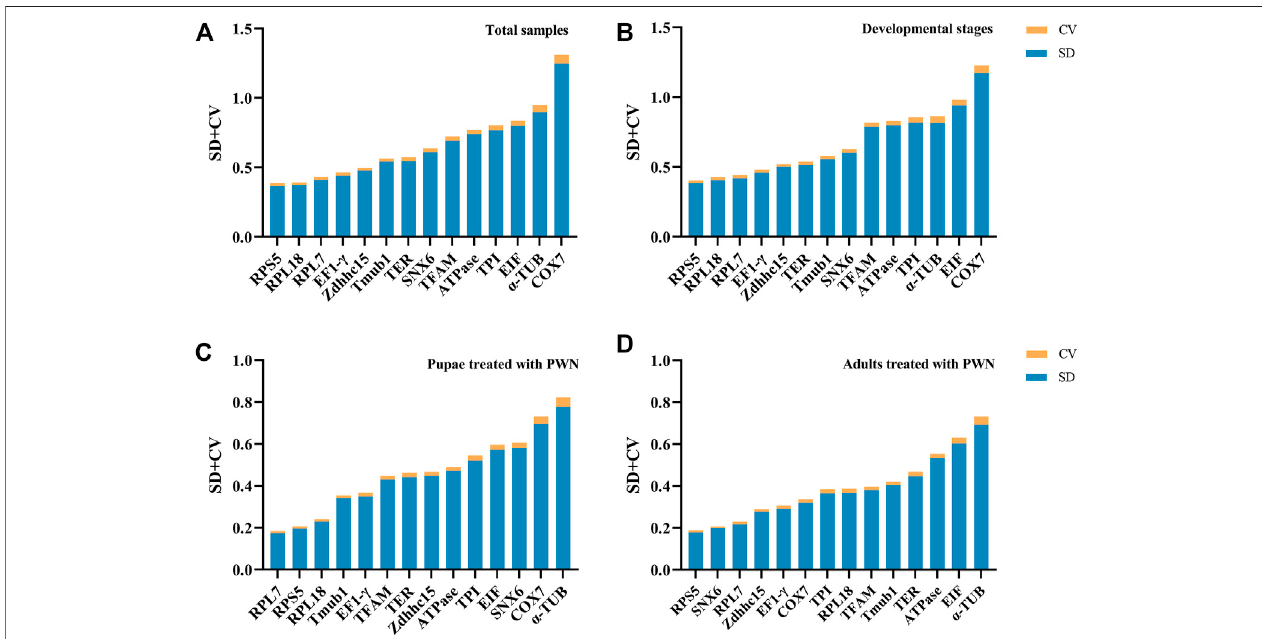
FIGURE 4 | Stability rankings of 14 candidate reference genes by BestKeeper. Blue bars represent standard deviation (SD) of average Ct values, and yellow bars represent coef fi cients of variation (CV). (A) Total samples. (B) Developmental stages associated with infection of PWN. (C) Pupae treated with PWN. (D) Adults treated with